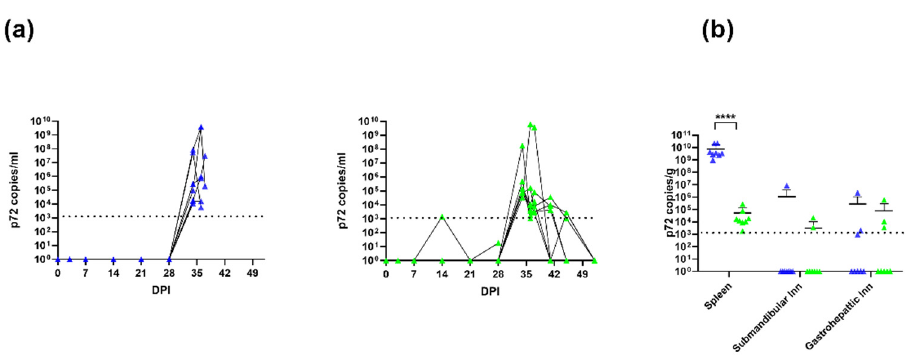
Figure 3. ASFV genome copies in blood and tissues. ( a ) p72 copies in EDTA blood after immunisa- tion with PBS (blue) or ASFV-Kenya-IX-1033- Δ CD2 (green) and challenge with ASFV-Kenya-IX- 1033. ( b ) p72 copies in spleen, submandibular lymph node and gastrohepatic lymph node of the eight animals challenged with ASFV-Kenya-IX-1033. The lower limit of detection of the qPCR was 1250 genome copies/mL or 1250 genome copies/g. When copy numbers were under 1250 genome copies/mL or g or when no Ct value was determined during qPCR, the value was registered as 10 0 copies/mL. Statistical analysis was carried out using multiple t-test. Asterisks indicate the statistical difference between experimental groups (**** p < 0.0001).